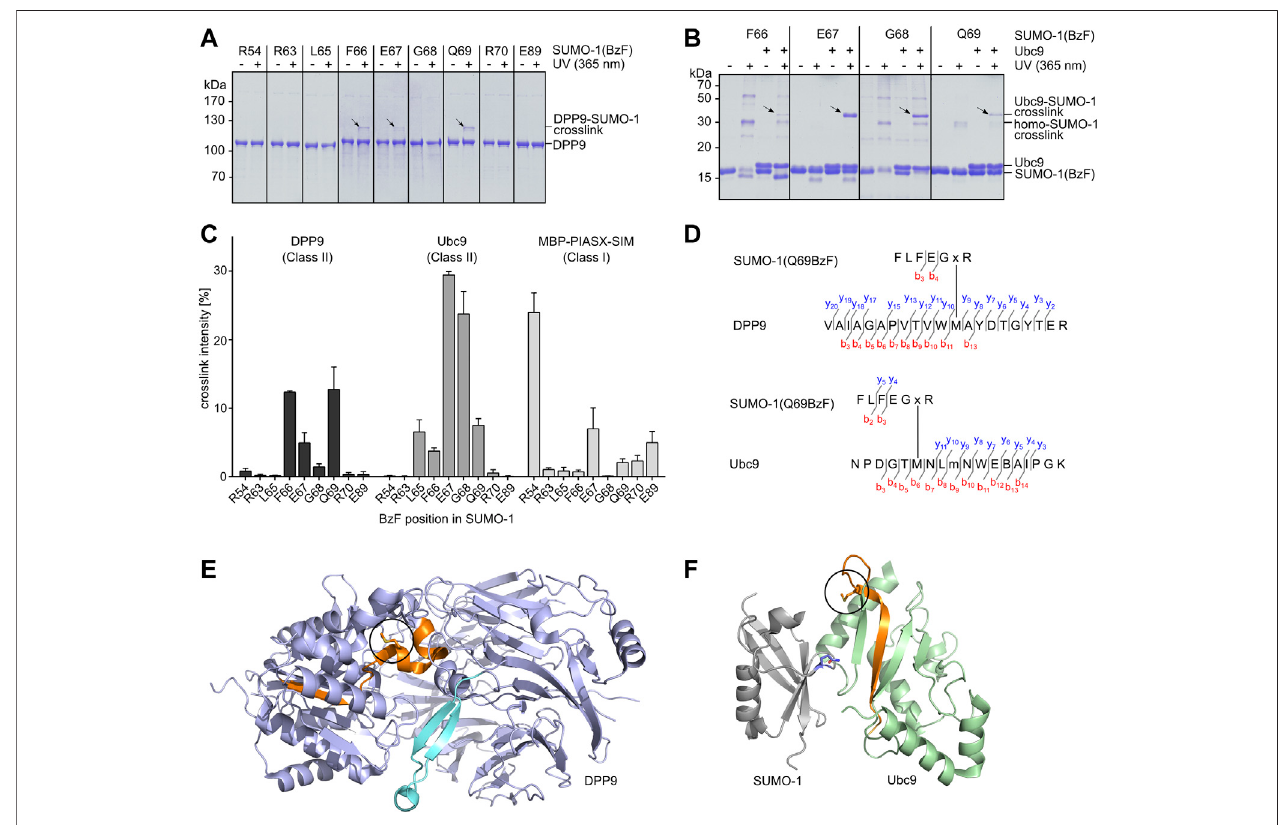
FIGURE 2 | Establishing SUMO-1 photo-crosslinking probes for class II interaction partners. (A) and (B) SUMO-1 probes with BzF at different positions along the E67-loop were incubated with DPP9 or Ubc9, respectively. Samples before and after UV-irradiation were analyzed by SDS-PAGE and Coomassie-staining. For complete SDS-Gels see Supplementary Figure S6 . (C) Densitometric analysis of crosslink ef fi ciencies using the binding partners DPP9, Ubc9 and MBP-PIASX-SIM for crosslinking, respectively. Experiments were performed in triplicate. (D) Tandem MS mapping of photo-crosslinks obtained for SUMO-1 (Q69BzF) with DPP9 (top) and with Ubc9 (bottom). Depicted in each case is one of the most likely crosslink positions. “ x ” represents BzF in SUMO-1 peptide. “ m ” indicates oxidized methionine. See Supplementary Figure S3 for MS/MS spectra. (E) Visualization of crosslinked peptide (highlighted in orange) in X-ray structure of DPP9 (pdb-code: 6EOQ). The crosslinked methionine is circled in black. (F) Crystal structure of Ubc9 in complex with SUMO-1 (pdb-code: 2UYZ) to visualize the crosslink of SUMO-1 (Q69BzF) with Ubc9. The crosslinked peptide is highlighted in orange and the methionine position is circled in black in the Ubc9 structure. Q69 in SUMO-1 is shown in sticks representation and in